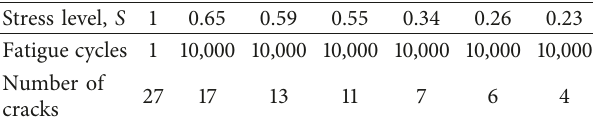
Table 4: The test results during the dynamic test. Stress level, S 1 0.65